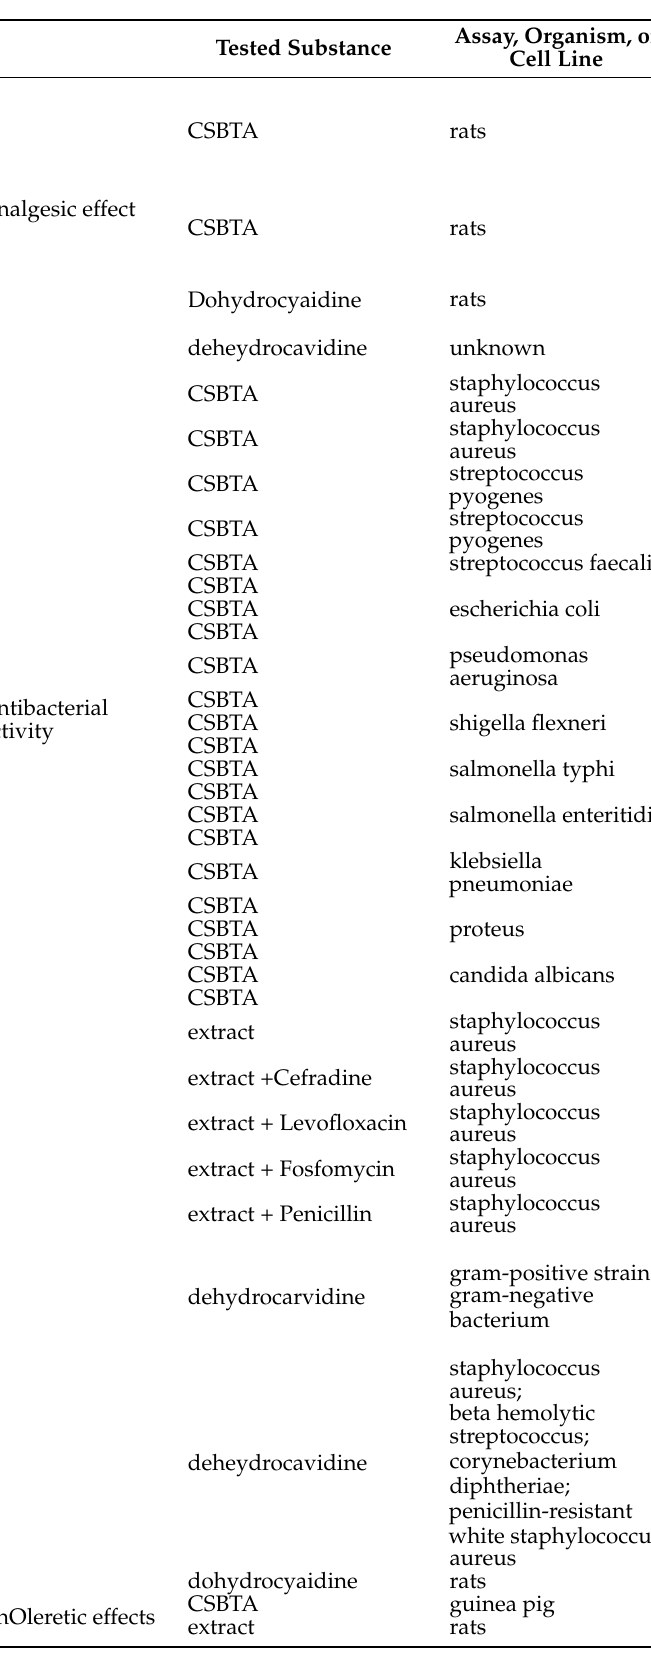
Assay, Organism, or Cell